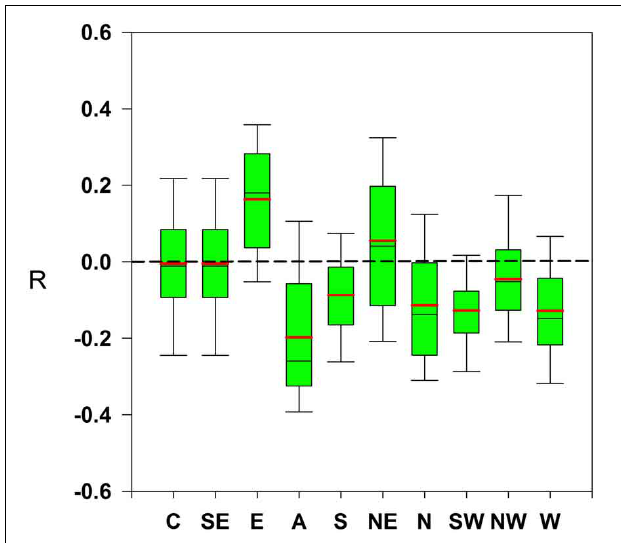
FIGURE 9 | Box-plot of Pearson correlation values between the mean frequency of the defined weather types and rainfall totals (mm) during the spring, calculated for 87 observatories. Statistical significance was assessed at α < 0.05. The description of box plots is the same as Figure 7